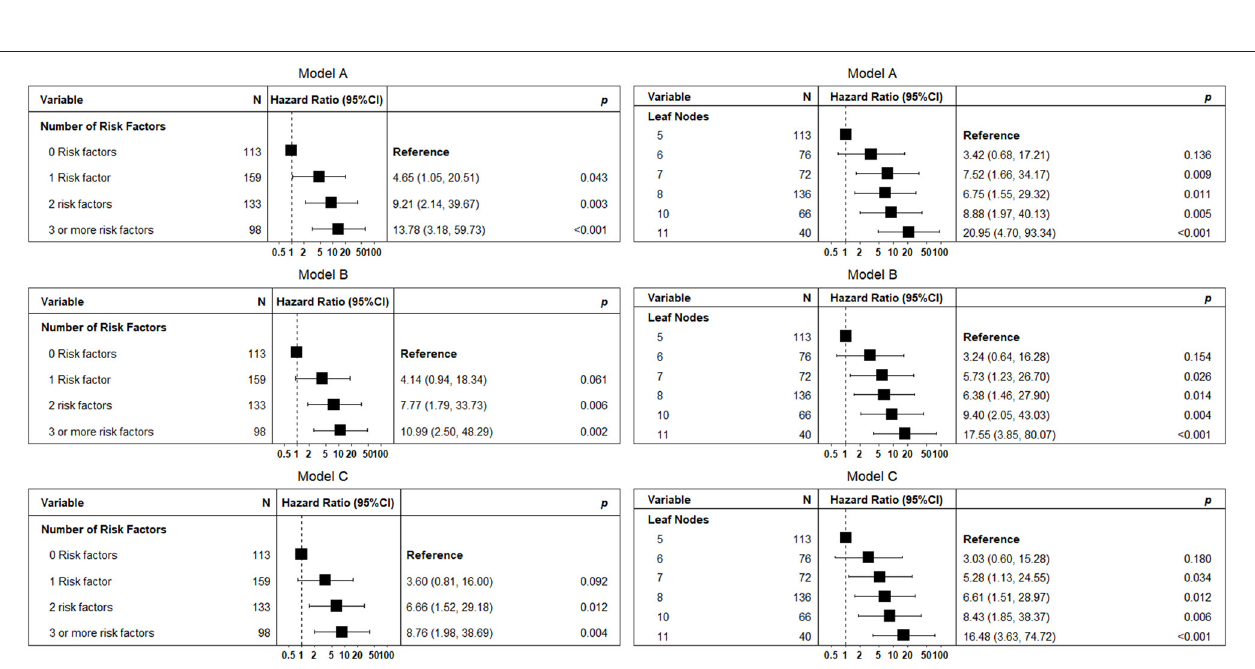
FIGURE 3 | A forest plot showing the hazard ratio and 95% CIs associated with several selected risk factors (panel A) and leaf nodes (panel B), with time to 1-year mortality as the dependent variable. Squares represent the hazard ratio and the horizontal bars extend from the lower limit to the upper limit of the 95% CI of the estimate of the hazard ratio. Model A: adjusted for age and sex; Model B: adjusted for age, sex, and number of medications and diagnoses; and Model C: as for model B with heart failure, hypertension, coronary artery disease, cancer, and atrial fibrillation instead of several diagnoses.